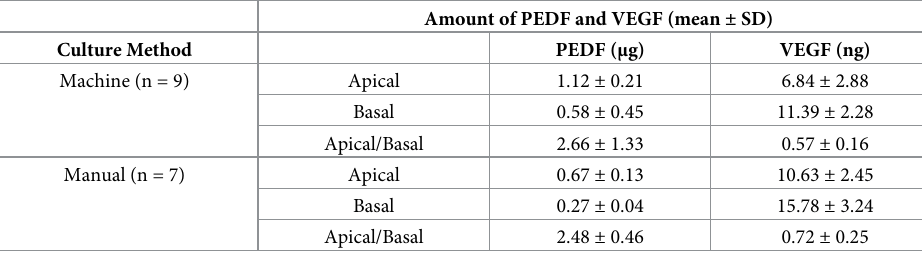
Table 1. Amount of proteins secreted into media of hiPS-RPE cell sheets over 24 h at 48 days after seeding. Amount of PEDF and VEGF (mean ±